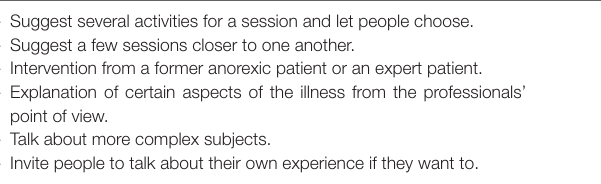
TABLE 4 | List of wishes in the second ludic